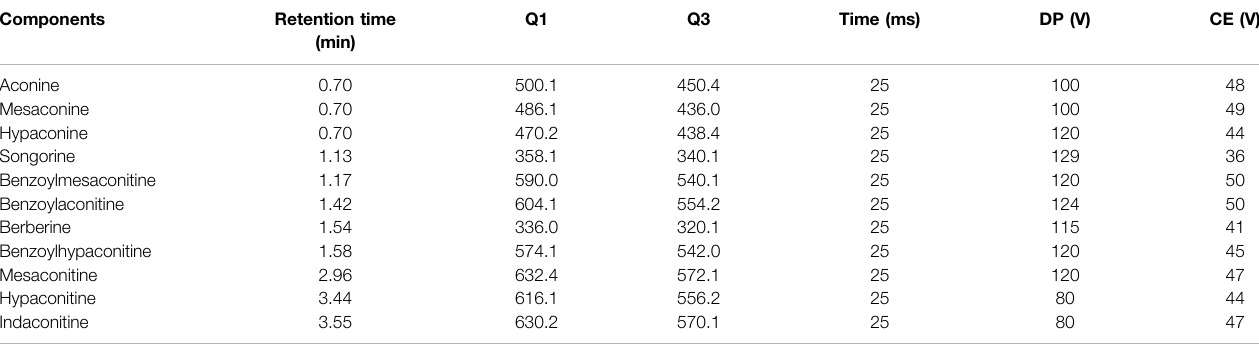
TABLE 1 | Ion pairs and the detailed parameters in MRM mode.